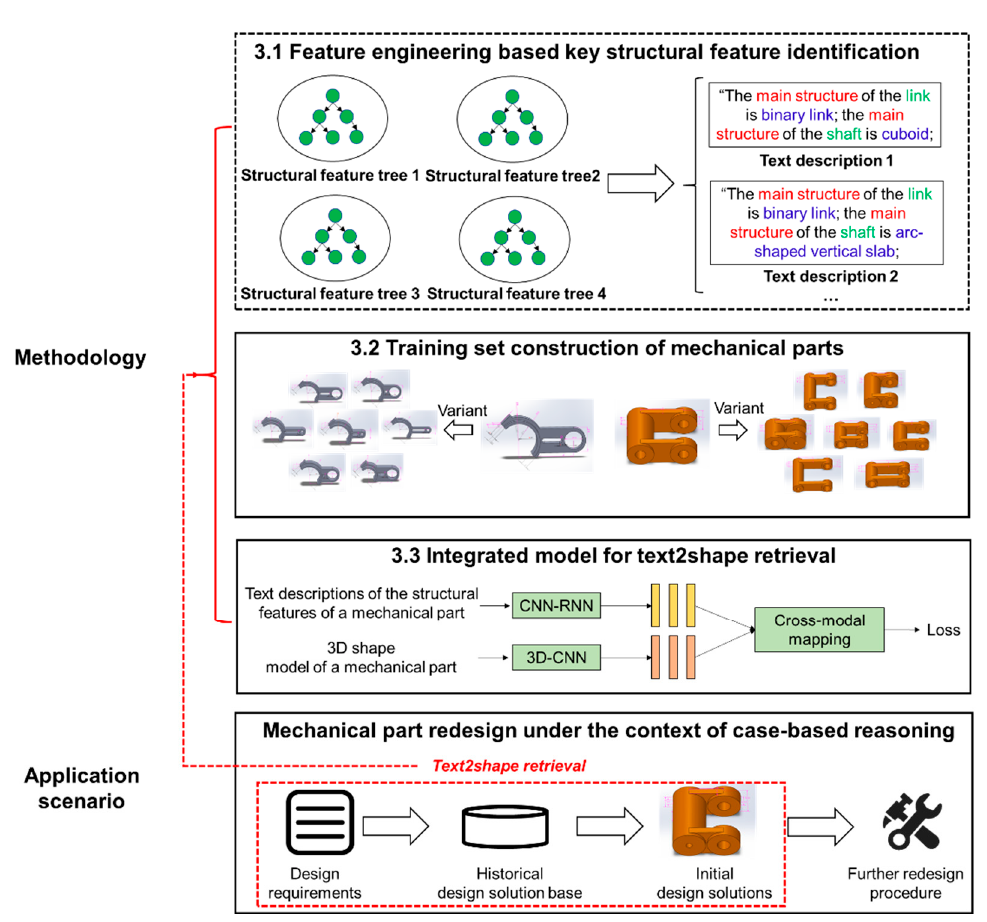
Figure 1. The application scenario and construction steps of the text2shape retrieval model.